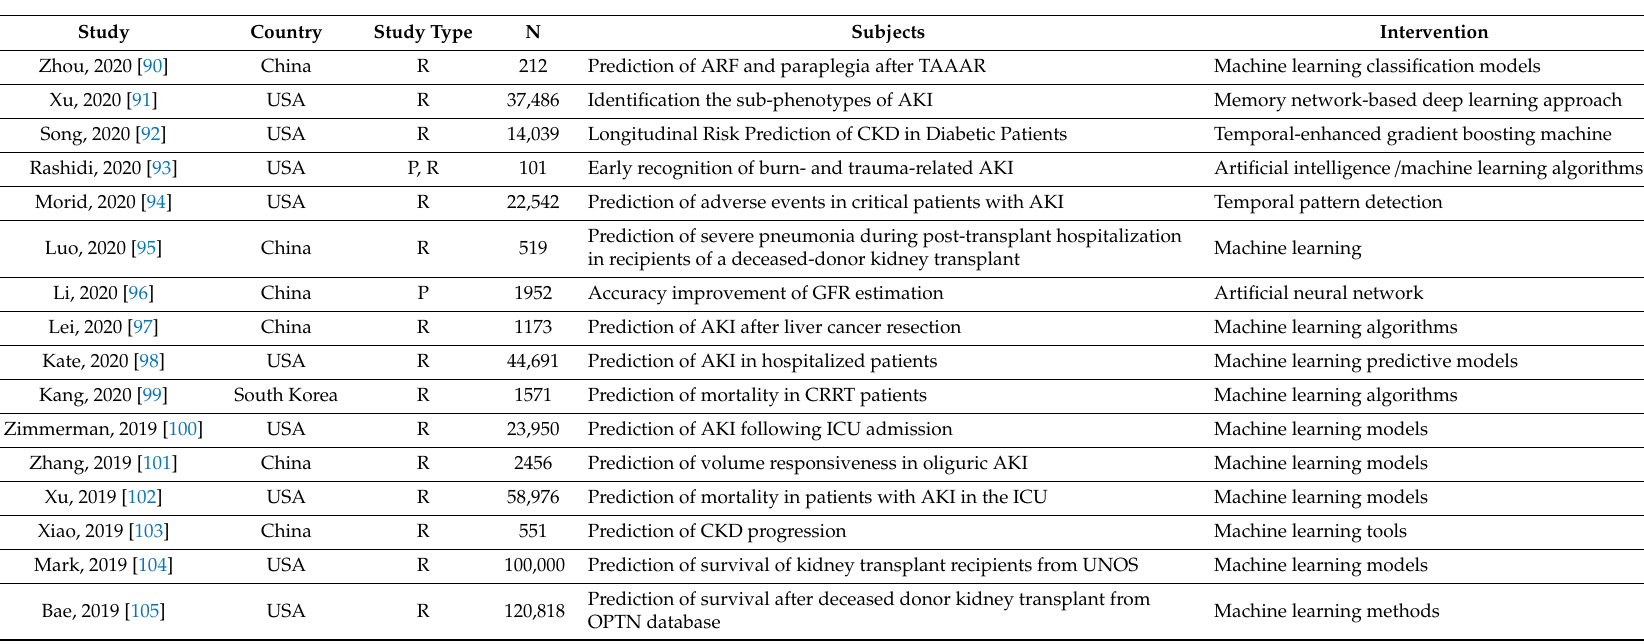
AKI, acute kidney injury; ARF, acute renal failure; AUC, area under curve; CKD, chronic kidney disease; CRRT, continuous renal replacement therapy; GFR, glomerular filtration rate; ICU, intensive care unit; OPTN, Organ Procurement and Transplantation Network; P, prospective; R, retrospective; TAAAR, thoracoabdominal aortic aneurysm repair; UNOS, United Network for Organ